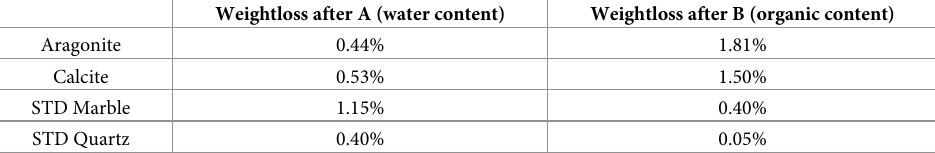
A = 105˚C for 1h, B = 500˚C for